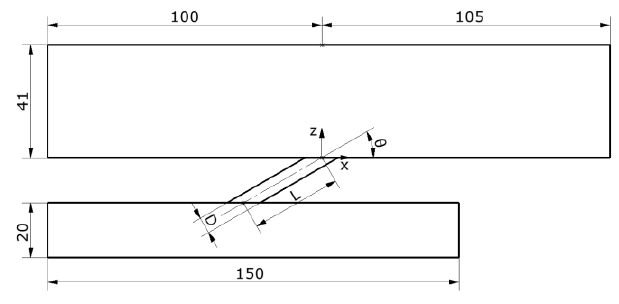
Figure 2. Geometrical parameters of CH case.